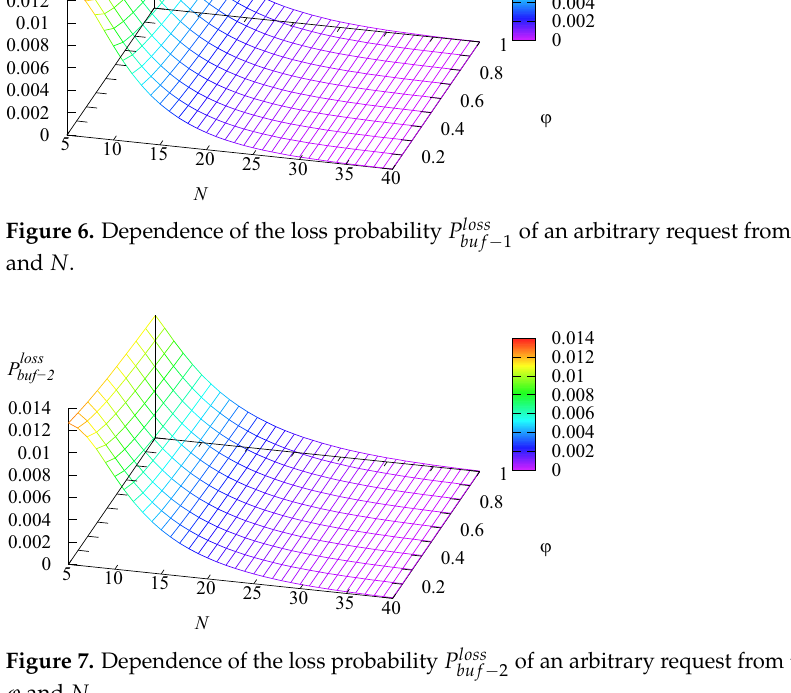
of an arbitrary request from the second buffer on buf − 2